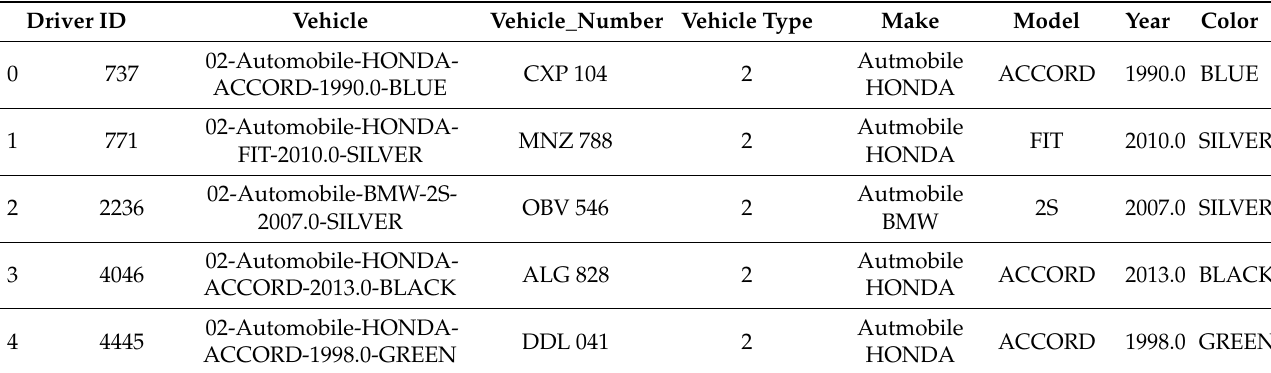
Table 3. Generated drivers and vehicle dataset.